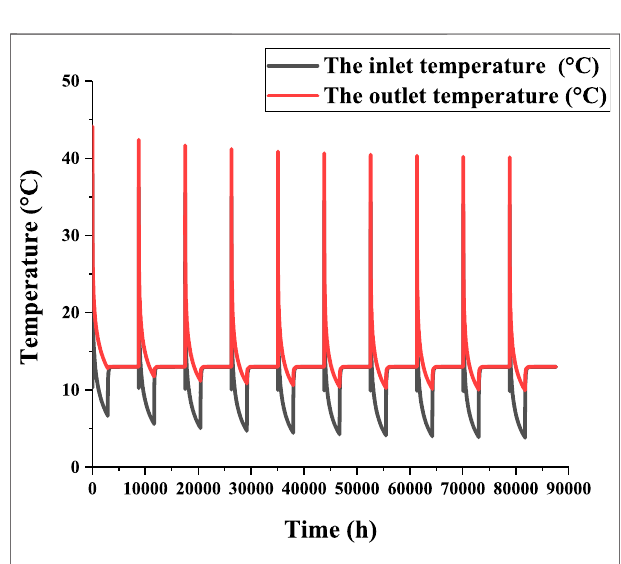
FIGURE 10 | Change in inlet and outlet temperatures over